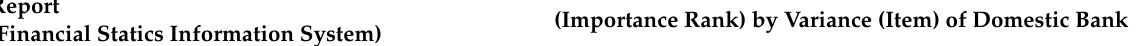
Table 6. 38 Important Predictors According to Random Forest RFE by Machine Learning